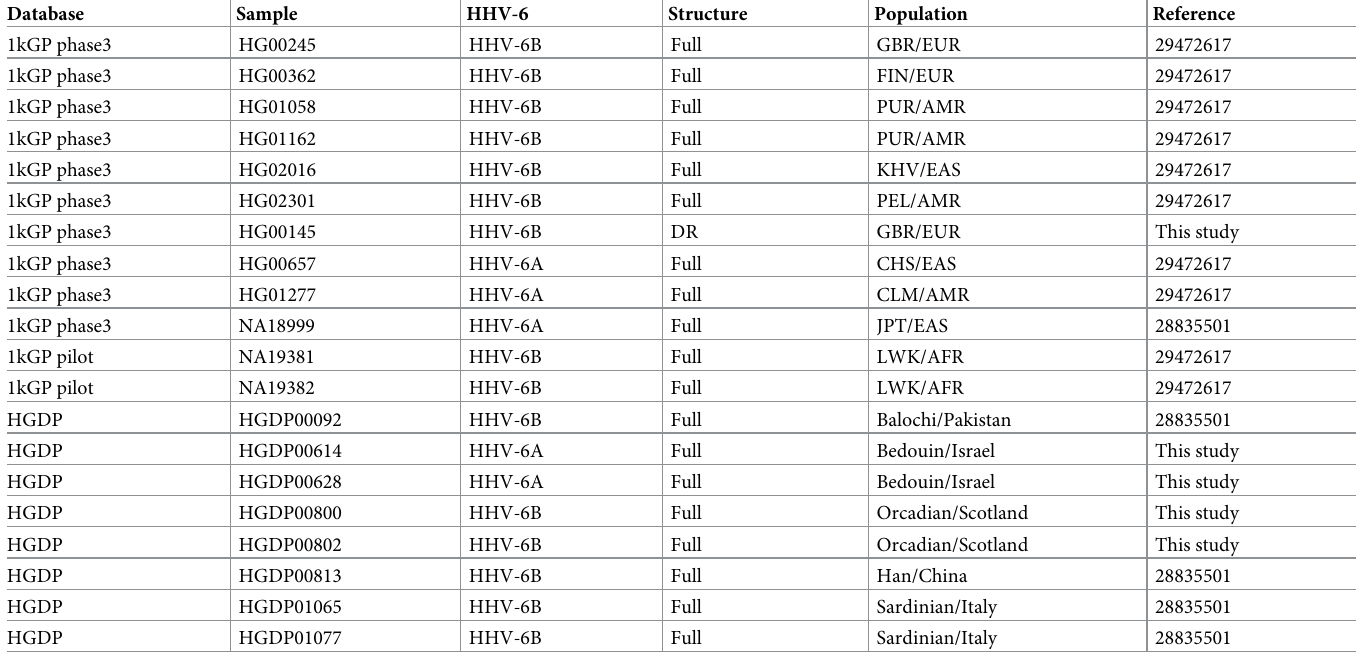
Table 1. Summary of integrated HHV-6 identified from 1kGP and